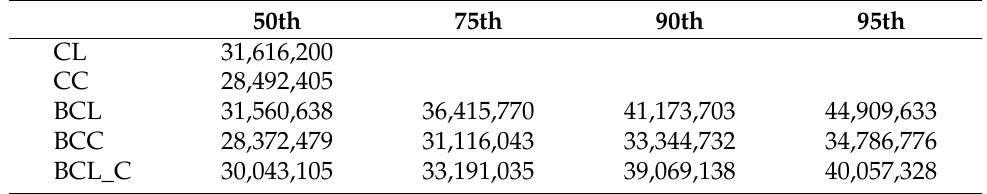
Table 13. Computed quantiles of reserves with outlier using the heat equation in two dimensions.